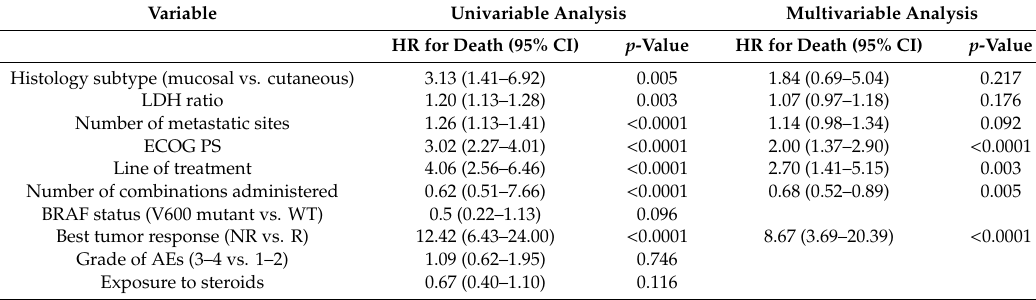
Table 4. Uni-and multi- variable